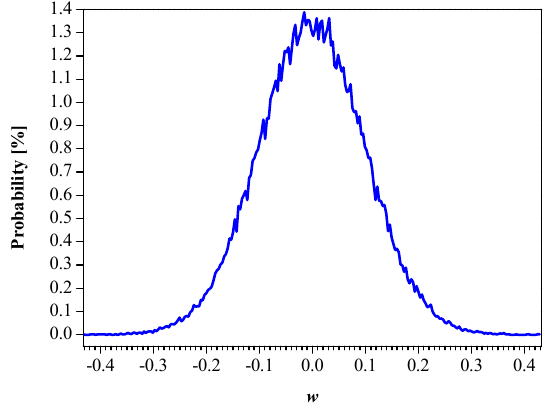
Figure 15. Distribution of learned weights for the considered MLP neural network.